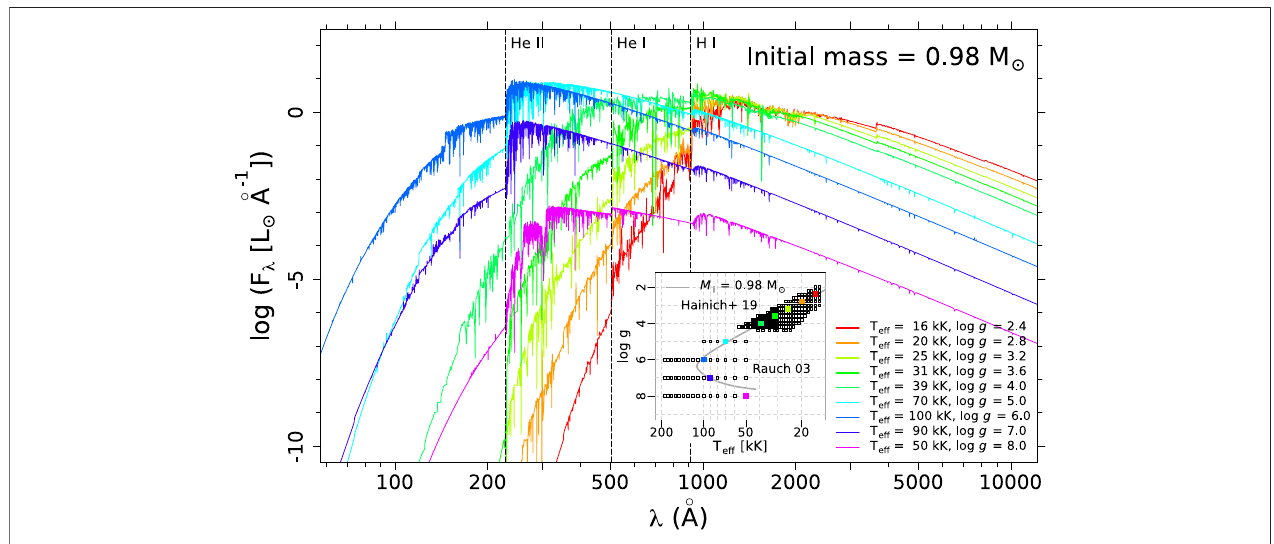
FIGURE1| Evolutionofthespectrumofastarwithinitialmassof0.98 M ⊙ andsolarmetalicity.TheinnerpanelshowstheHOLMESevolutionarysequencebyMiller Bertolami (2016) ( grey line ) and the parameters (effective temperature and surface gravity) ofstars in the Rauch (2003) and Hainich et al. (2019) libraries of stellar spectra ( open squares ). The coloured squares indicate the parameters of the stars for which spectra are shown in the main panel. The star takes 3.4Myr to evolve from the fi rst ( red ) to the last ( purple ) phase shown in this Figure.